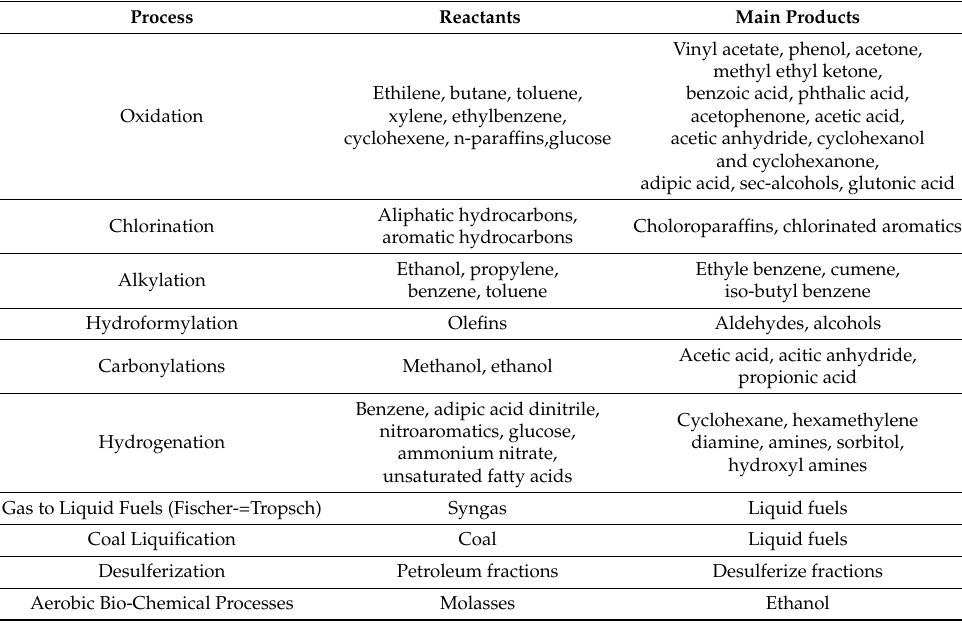
Table 1. Main applications of bubble column reactors